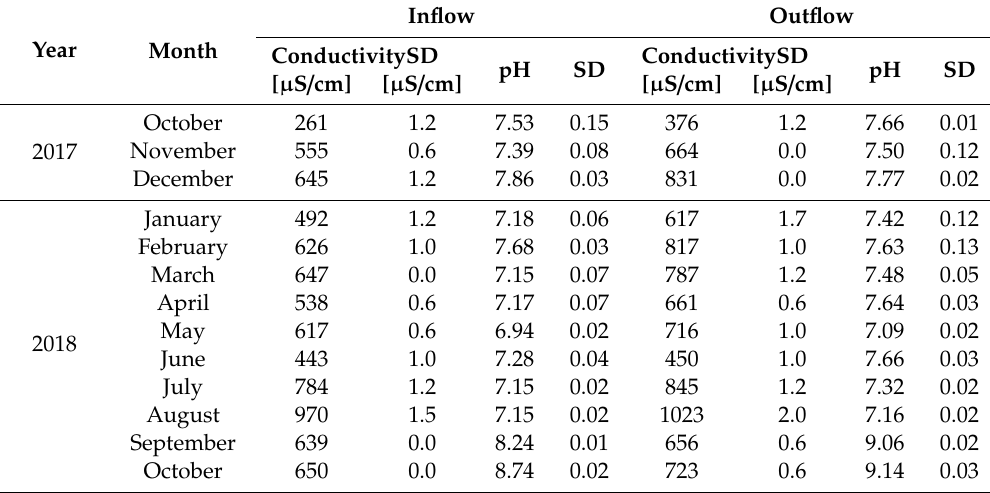
Table 9. Monitored parameters of inflow and outflow water at Site A.